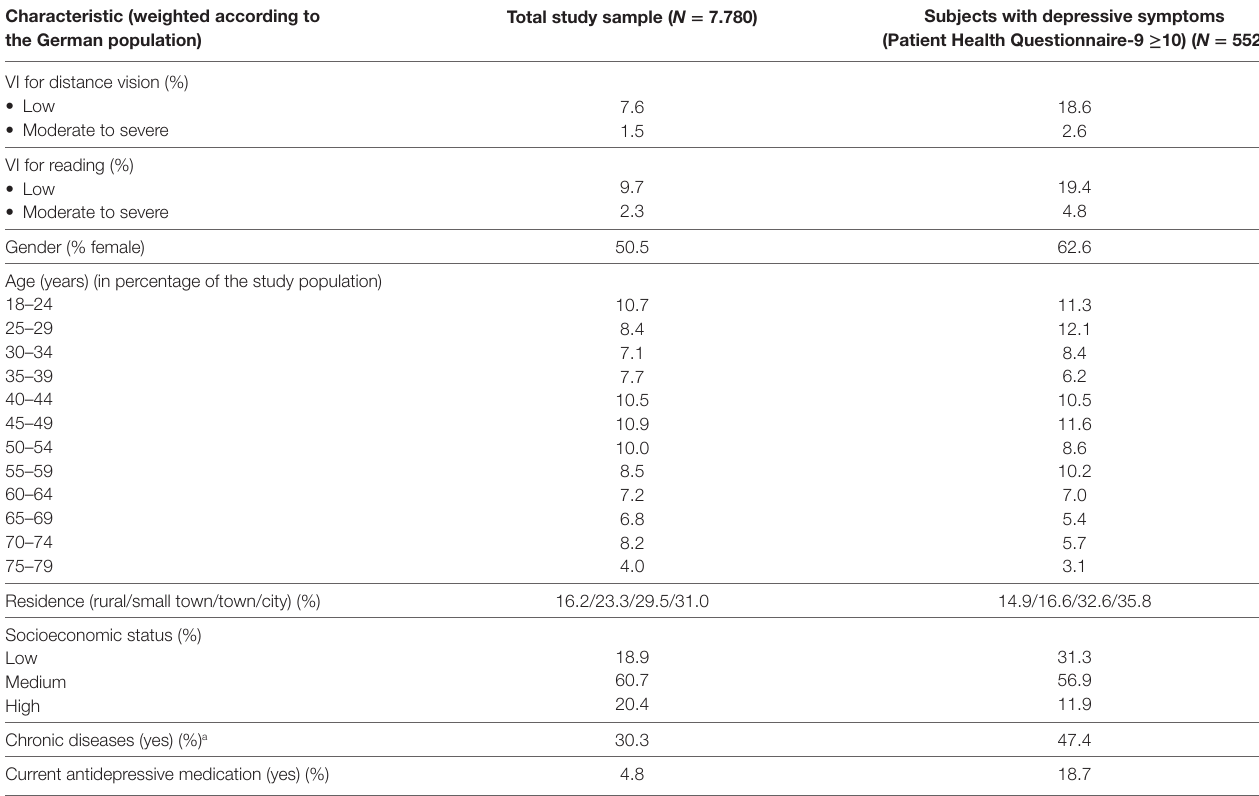
Total study sample ( N =